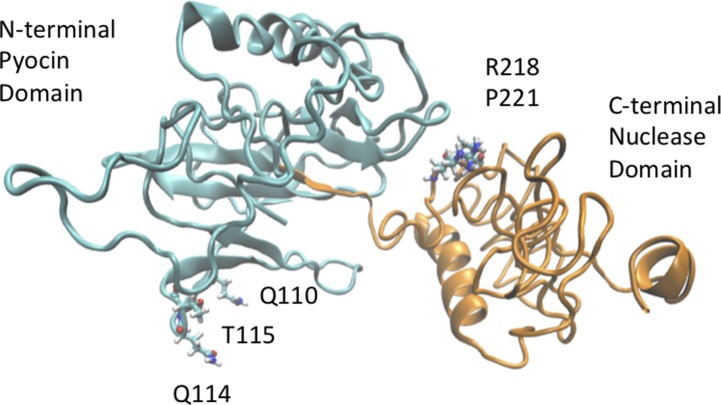
A three-dimensional model of USP was generated using i-TASSER (Eren et al., 2013) and visualized using VMD (Vogtmann et al., 2016) to show the location of possible sites of amino acid variation. Position 110 within the pyocin-like domain of USP (cyan domain) can be occupied either by a Leu or Gln residue. Similarly, positions 218 (Arg/His) and 221 (Leu/Pro) of the nuclease domain (green domain) are also hotspots of sequence variation.